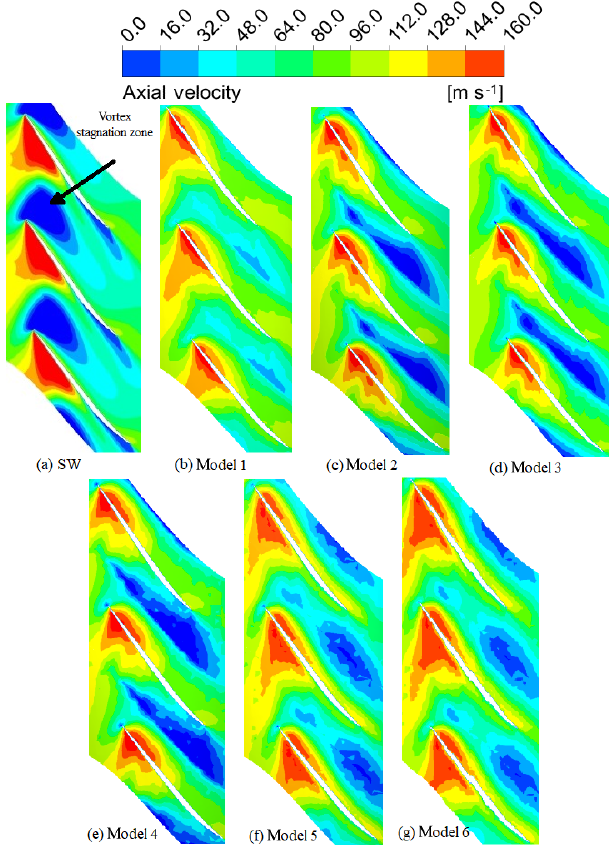
Figure 8. The contours of Axial velocity for smooth casing and models 1–6 at 98% span close to stall point.